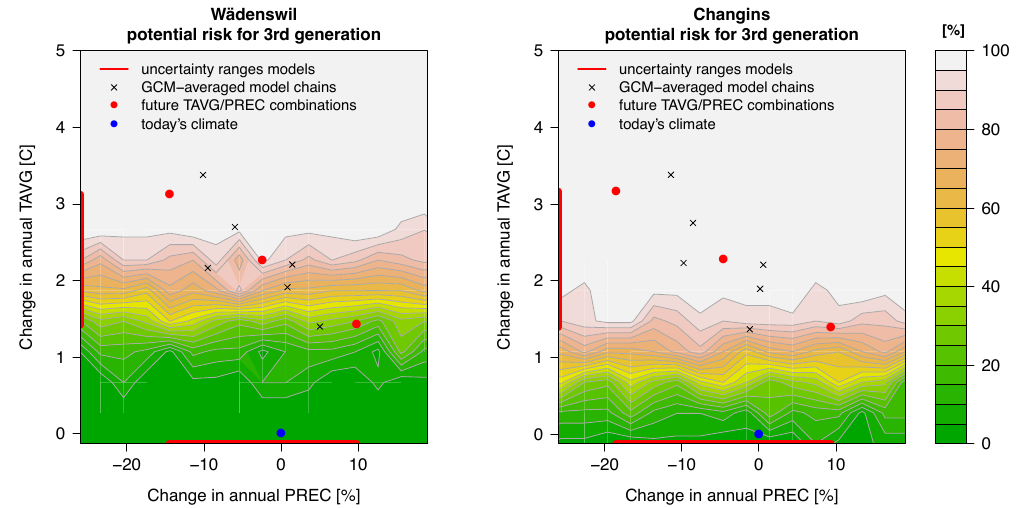
Fig. 6. Impact response surfaces of the potential risk for 3rd generation larvae at the stations W¨adenswil (left panel) and Changins (right panel). The blue dot marks the potential risk in today’s climate and the red dots refer to the three considered future combinations of temperature and precipitation changes (see Sect. 2.1). The crosses mark the raw model projections averaged according to the driving GCM. The red lines along the x- and y-axes display the posterior uncertainty ranges of the model-projected changes in annual temperature and precipitation. The posterior distributions of these climate change signals were determined through application of the Bayesian multi-model combination algorithm independently to temperature and precipitation (Fischer et al., 2011). However, previous analyses of GCM/RCM outputs (e.g. Sch¨ar et al., 2004; Vidale et al., 2007) have shown that for the Alpine region, changes in temperature and precipitation tend to be negatively correlated, at least during the summer season, a tendency also found here with respect to the distribution of temperature and precipitation changes for the GCM-averaged model